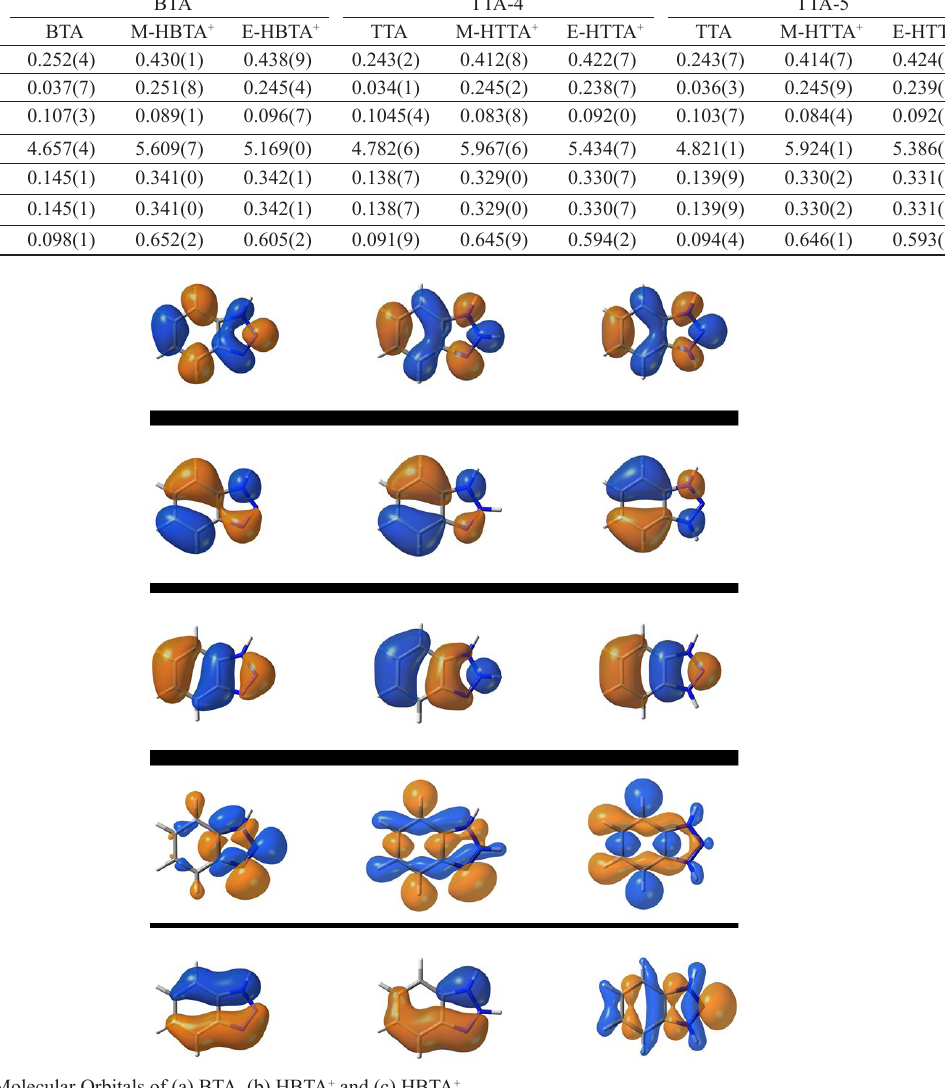
Table 7. Calculated theoretical quantum parameters of BTA, TTA-4 and TTA-5. BTA